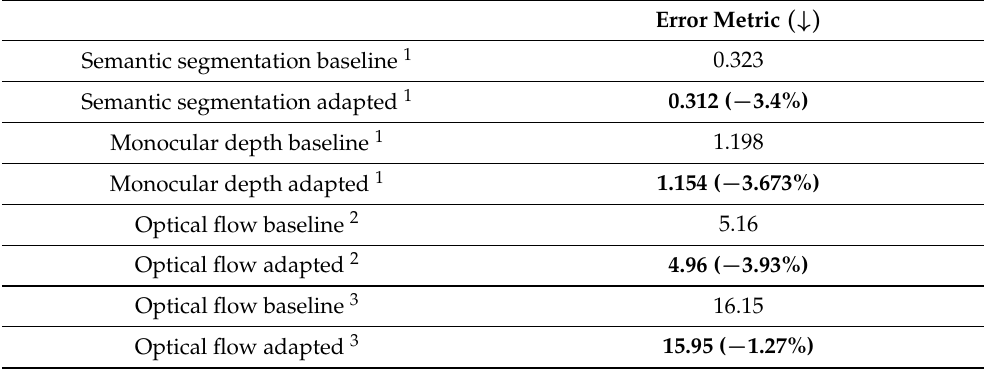
For each comparison, the best results are in bold . 1 Evaluated on RWFOREST 256 × 256. 2 Evaluated on OmniFlowNet. 3 Evaluated on